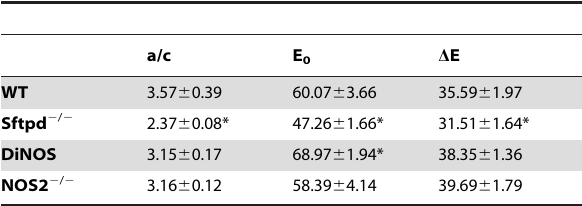
Table 4. Surfactant homeostasis is not corrected by additional NOS2 genetic